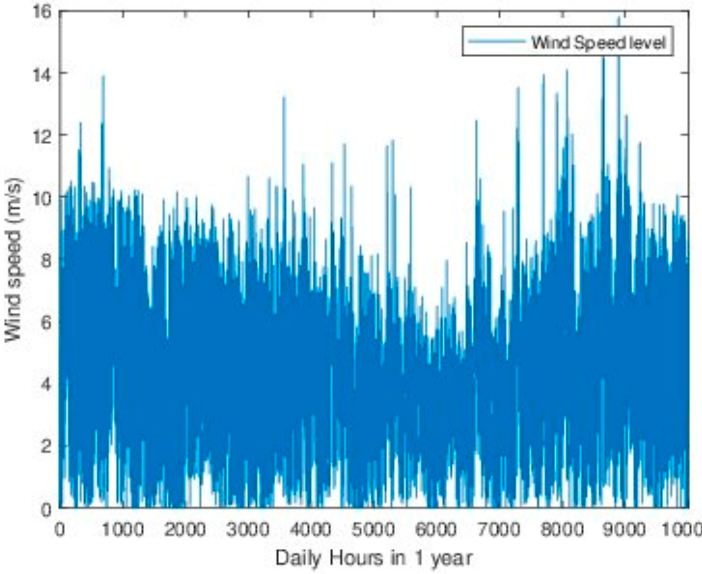
Figure 18. Wind velocity data set. The network is trained by adjusting the values of hidden layers and delays. The best result comes out to be at the hidden layers of size 8 and delays of 8 units. In order to check the versatility of the model, various plots have been recorded. The various statistical plots associated with the model as observed are shown in Figures 19–24.